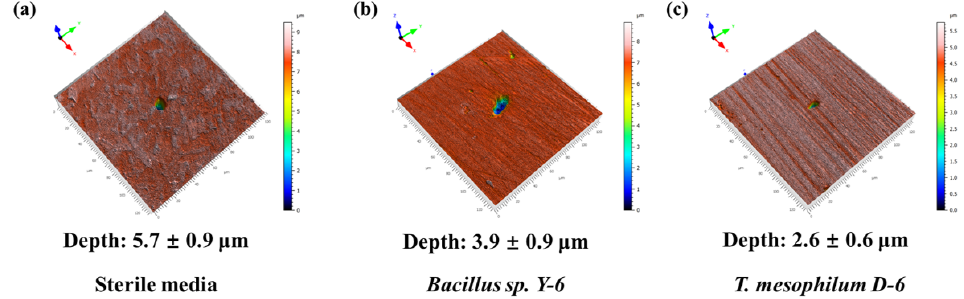
Figure 5. The averaged maximum pitting depth of Q235 coupons at the end of the 7-day incubation in different culture media: ( a ) sterile media, ( b ) Bacillus sp. Y-6, ( c ) T. mesophilum D-6. Five maximum pitting depths measured in different regions on the coupon were averaged to obtain the averaged value.